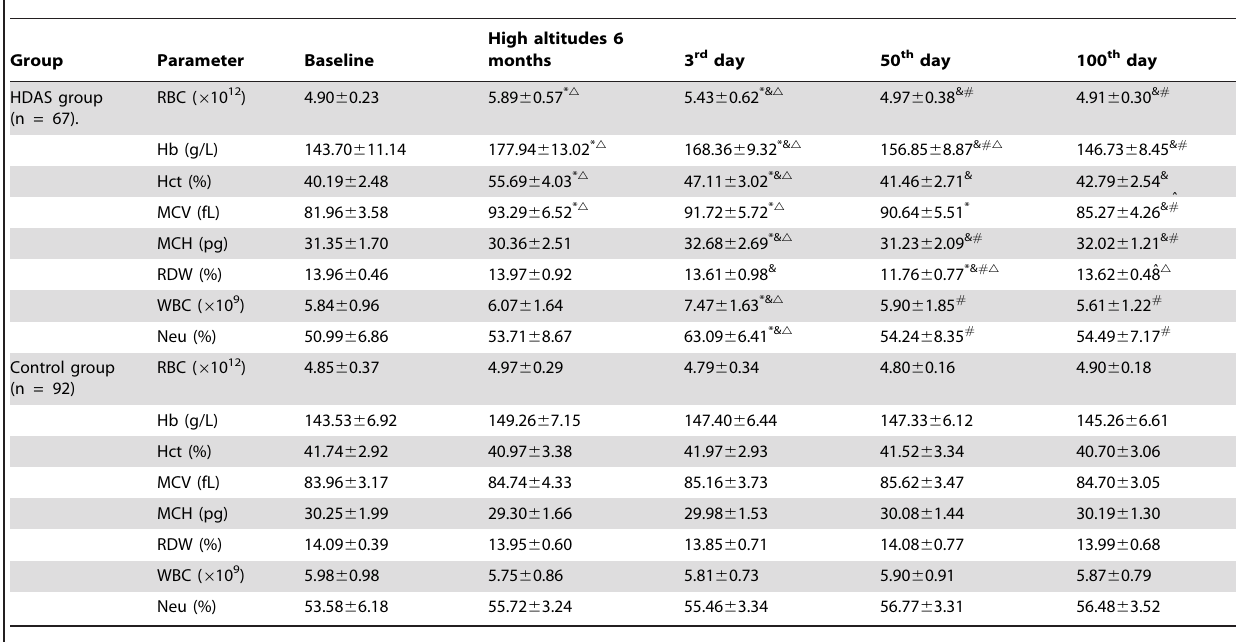
Data are given as the mean 6 SD. RBC = red blood cell, Hb = hemoglobin, Hct = hematocrit, MCV = mean corpuscular volume, MCH = mean corpuscular hemoglobin, MCHC = mean corpuscular hemoglobin concentration, RDW = red blood cell volume distribution width, WBC = white blood cell, Neu = neutrophil.